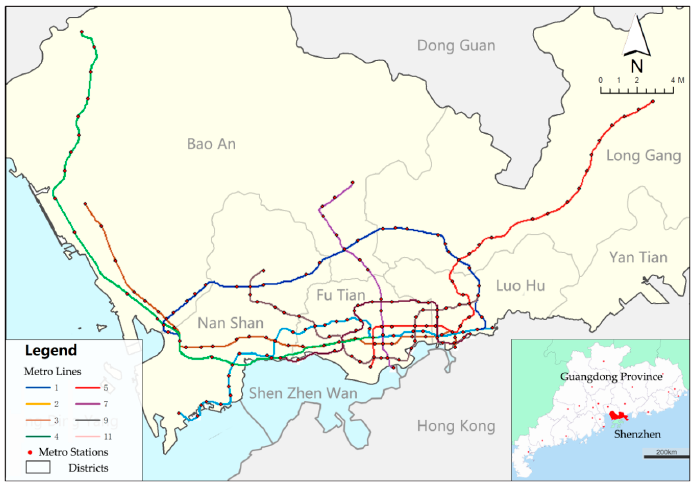
Figure 1. Location of Shenzhen and its metro lines.